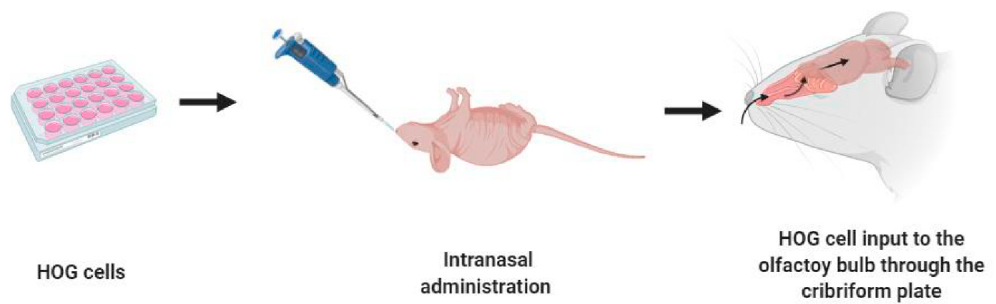
Figure 7. Schematic representation of the HOG cell administration process. HOG cells suspension was prepared and administered to mice intranasally. From the nasal sinus, HOG cells enter the olfactory bulb through the cribriform plate, spreading across the brain. Image created with BioRender.